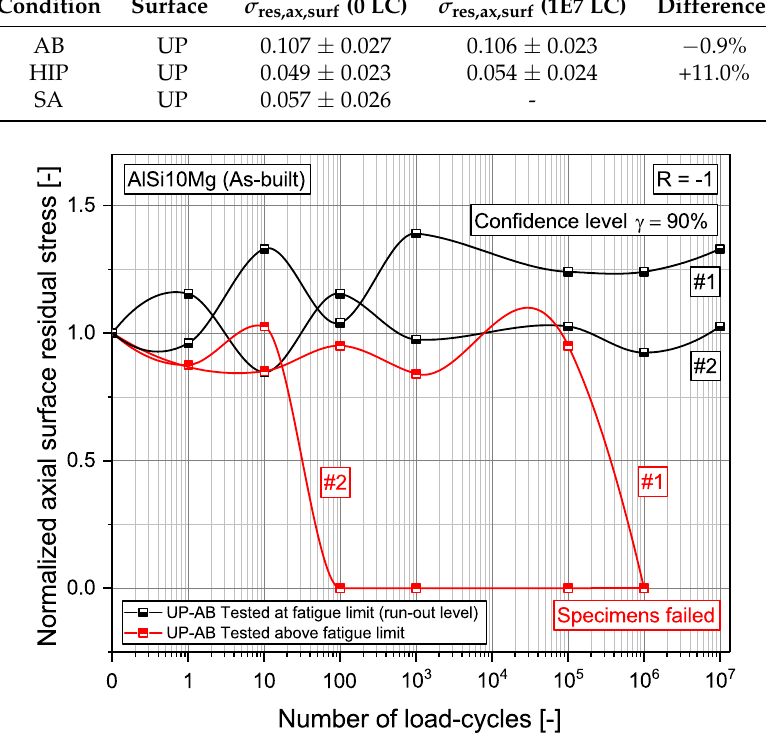
Figure 6. Cyclic stability of residual